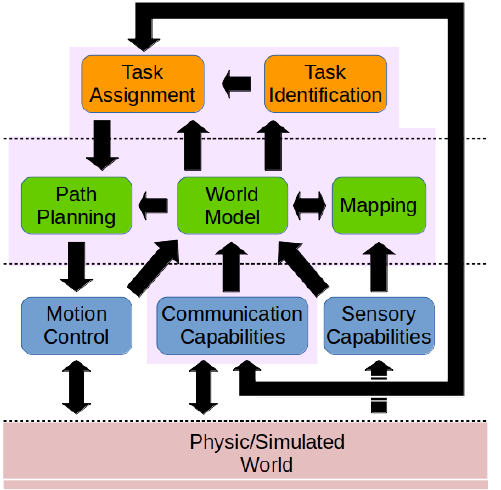
Figure 11. Robotic Agent Architecture. The first layer includes the software components that represent systems or devices through which the agent can interact with the environment. The second layer includes models and algorithms to keep the models up to date. The third layer includes the task identification and selection algorithms. Components on the shadowed zone were developed during this